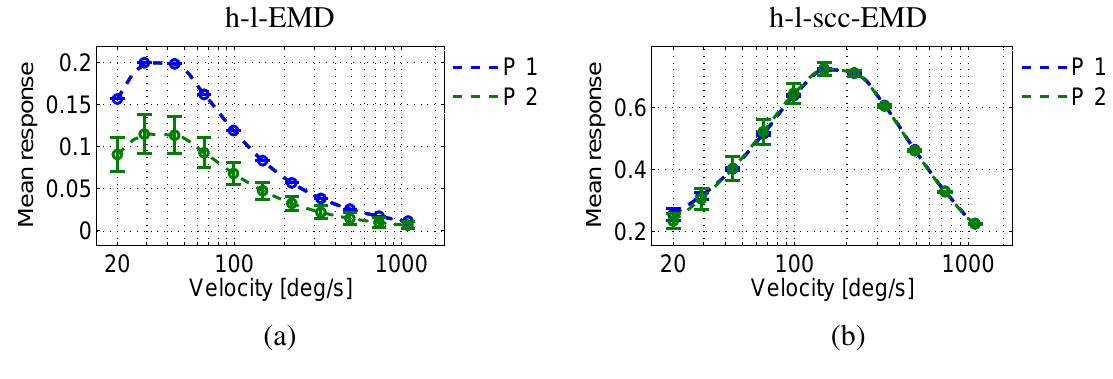
Figure 7. Velocity tuning of the different models for the perfect sine pattern (P 1) and the noisy panoramic sine pattern (P 2). (a) The h-l-EMD array shows strong differences in the responses whereas (b) the h-l-scc-EMD array shows only minor differences (curves are overlapping).